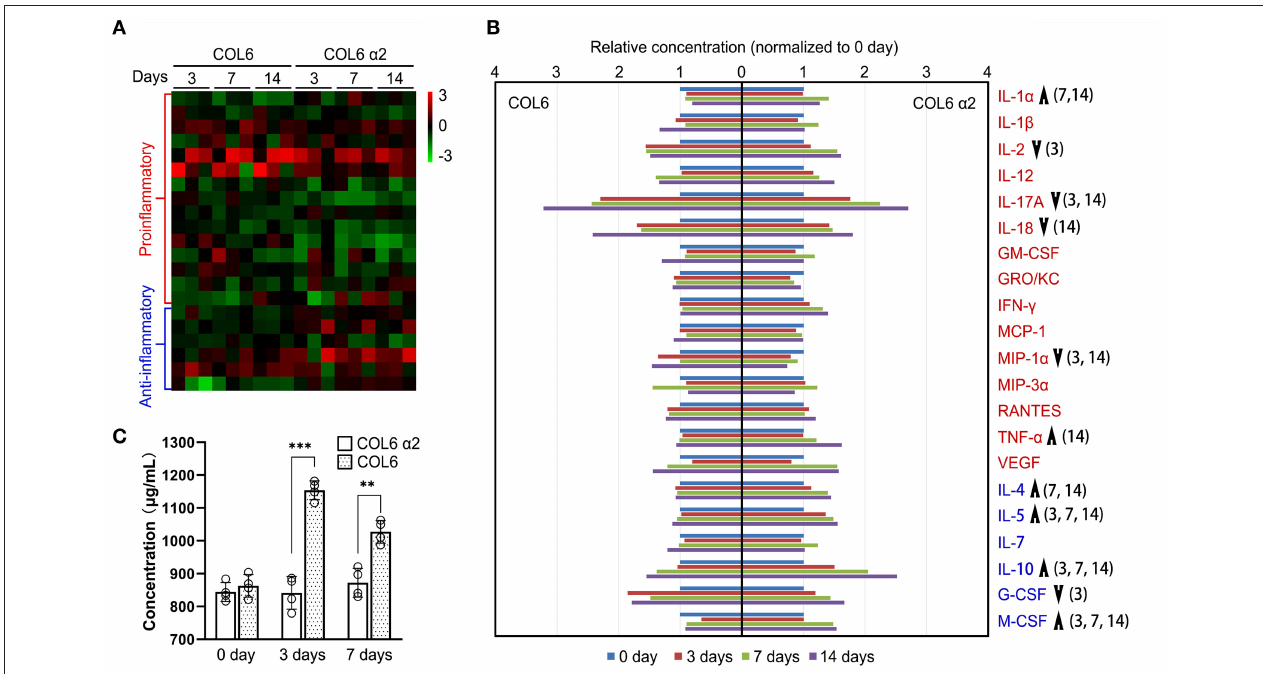
FIGURE 6 | Immunogenicity assessment of human-sourced COL6 α 2 and COL6 among rats. (A) Heatmap of cytokine expressions in COL6 and COL6 α 2 immunized rat serum at 3, 7, and 14 days; the order of cytokines was consistent with that in (B) . (B) Relative expression levels of each pro-inflammatory cytokine (red font) and anti-inflammatory cytokine (blue font) were compared between COL6 and COL6 α 2. Up and down arrows respectively indicate higher and lower levels of cytokine in COL6 α 2, compared with COL6. The numbers in brackets indicate statistical differences between the groups on specific days [three independent biological experiments were performed in (A) and (B) ]. (C) Concentration of serum IgM at various time points, detected via ELISA ( n = 4 independent biological experiments, *** p < 0.0001, ** p = 0.0015 unpaired t